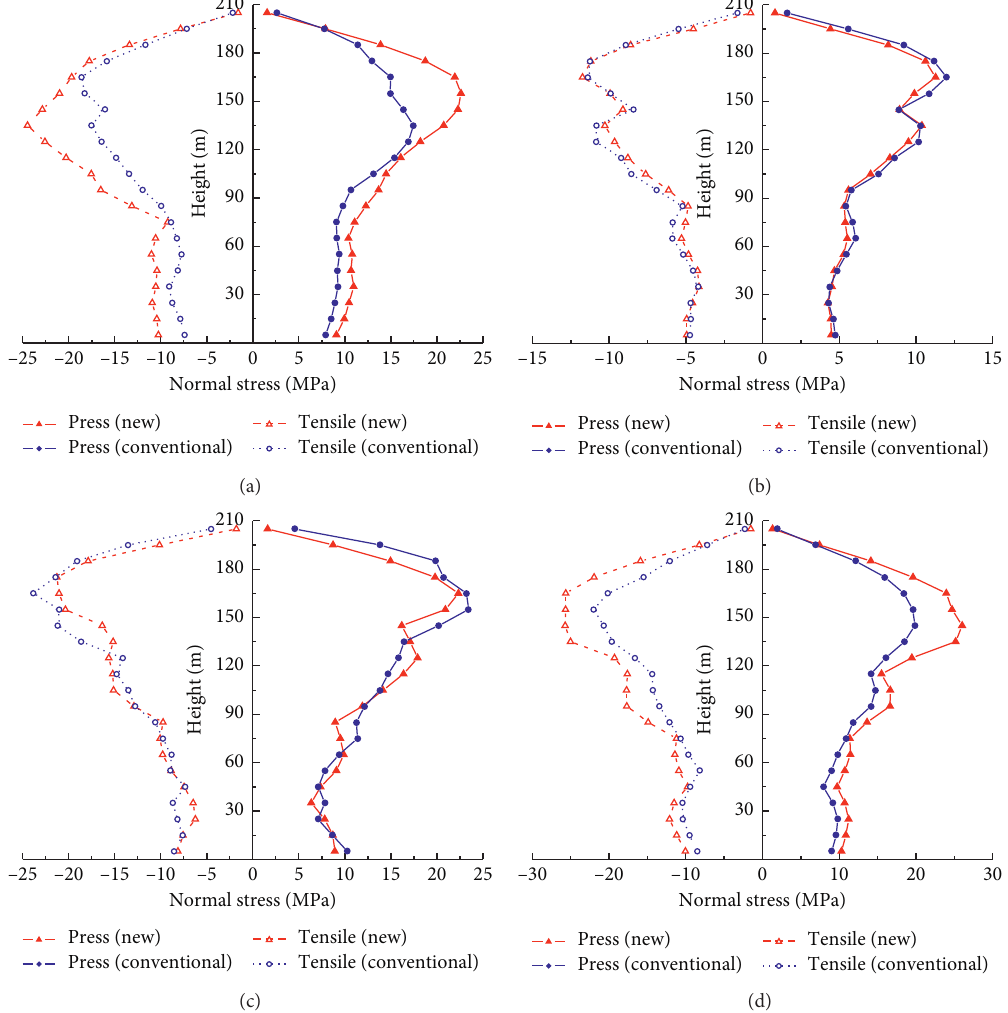
Figure 8: Spatial distributions of maximum earthquake normal stresses at different cross sections of the 210m high chimney under four earthquake wave actions: (a) Landers wave (No. 1); (b) Loma Prieta wave (No. 2); (c) Borrego wave (No. 3); (d) Chichi wave (No. 4).